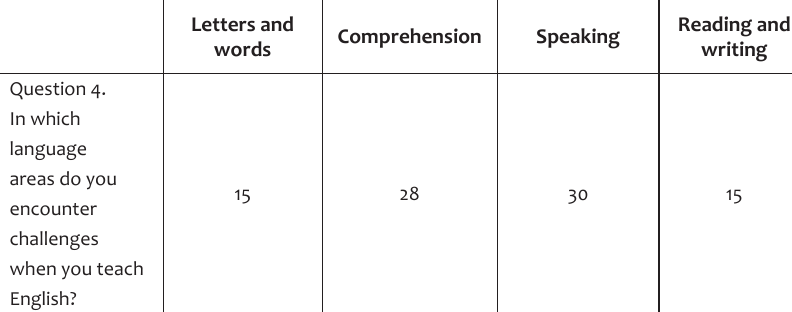
Table 7: Challenges encountered in teaching Letters and